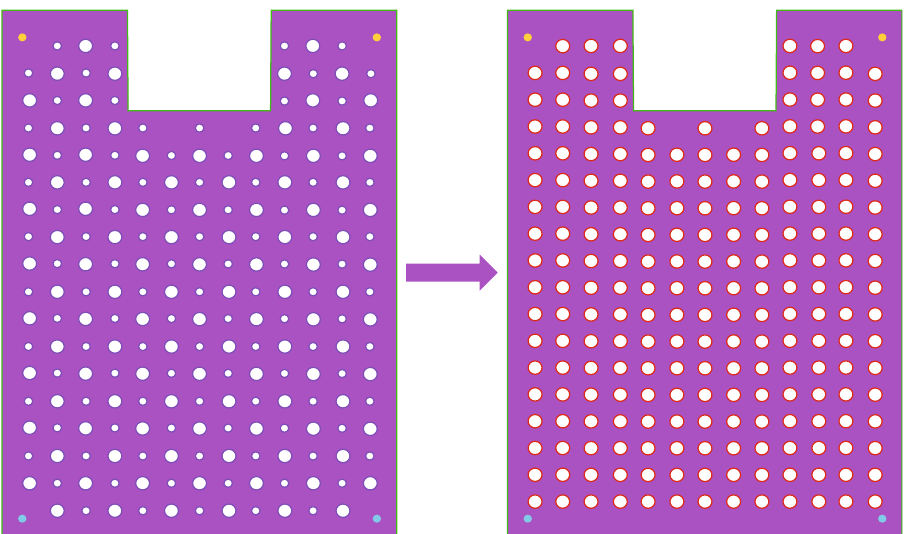
Figure 12: Heat absorber plate with changing all small corrugations to large ones (right).